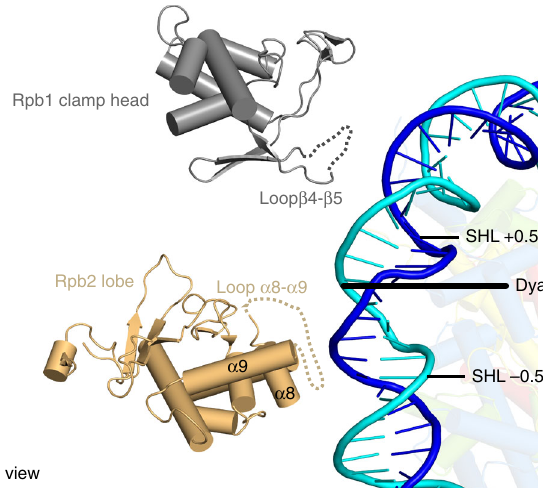
Fig. 2 Pol II – NCP contacts. Rpb1 clamp head and Rpb2 lobe domains contact nucleosomal DNA around the NCP dyad. Clamp head and lobe domains are shown. Loops contacting nucleosomal DNA are indicated